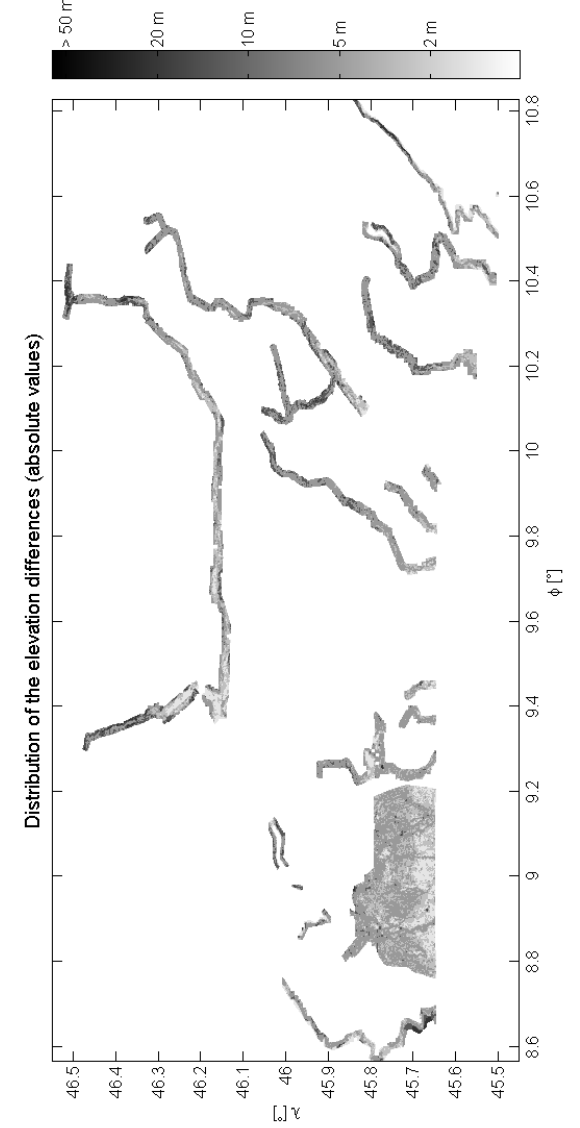
Figure 5. Planimetric distribution of the height differences between HR and LR DTMs.